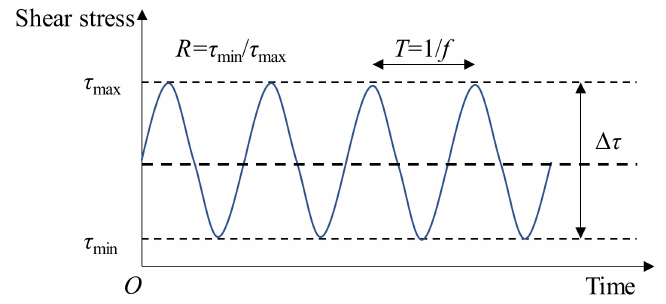
Figure 8. Main parameters in fatigue loading.